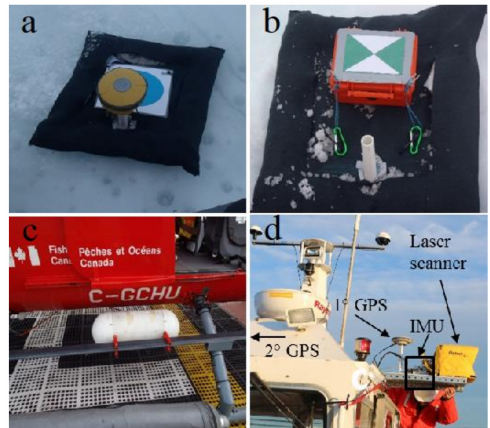
Figure 2. Surveying equipment: ( a ) Marker paired with a dual-frequency GPS (Topcon Hiper V) unit, ( b ) Marker paired with a tracking beacon (Solara FT2000), ( c ) external mount for the Nikon D7100, and ( d ) frame-mounted Optech Ilris laser scanner, inertial measurement unit (IMU), and GPS antennas. The second GPS antenna is situated out-of-sight on the far end of the frame. The GPS baseline was 3.3